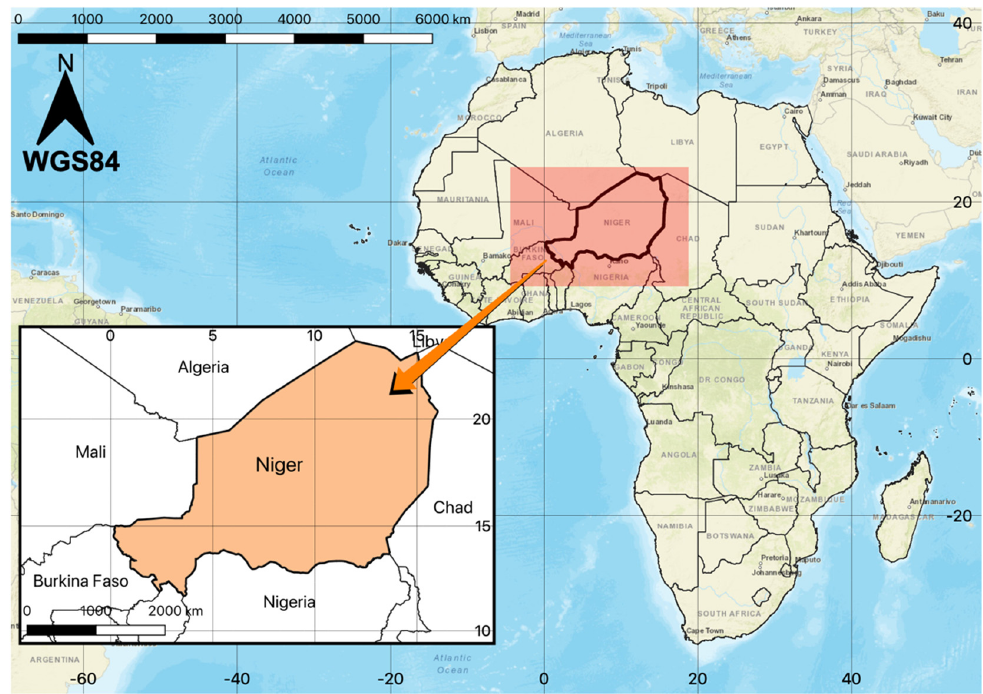
Figure 1. The location of Niger and its adjacent countries in the African continent.